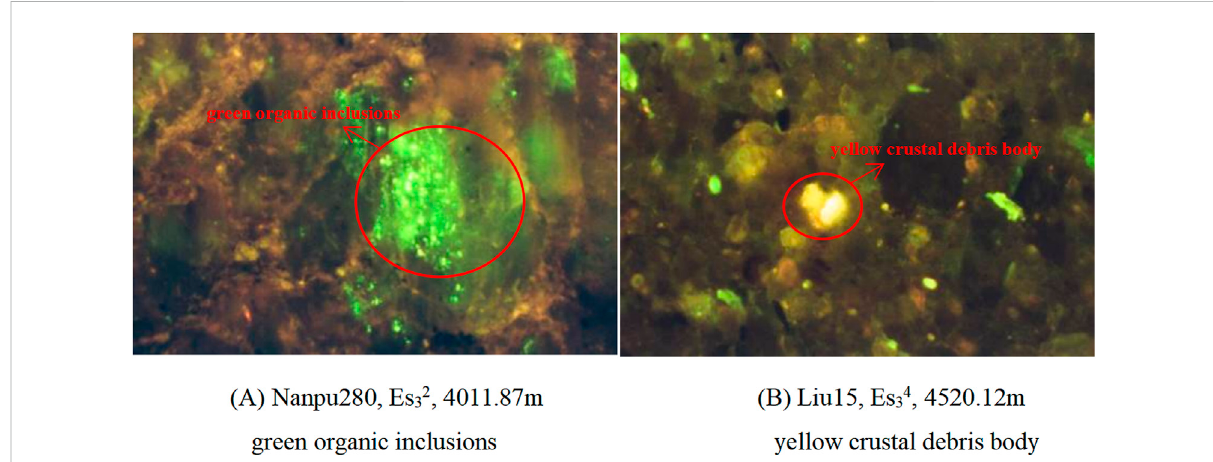
FIGURE 3 Group of maceral photographs of Es 3 source rocks in Nanpu Sag. (A) Nanpu280, Es 3 2 , 4011.87 m green organic inclusions. (B) Liu15, Es 3 4 , 4520.12 m yellow crustal debris body.